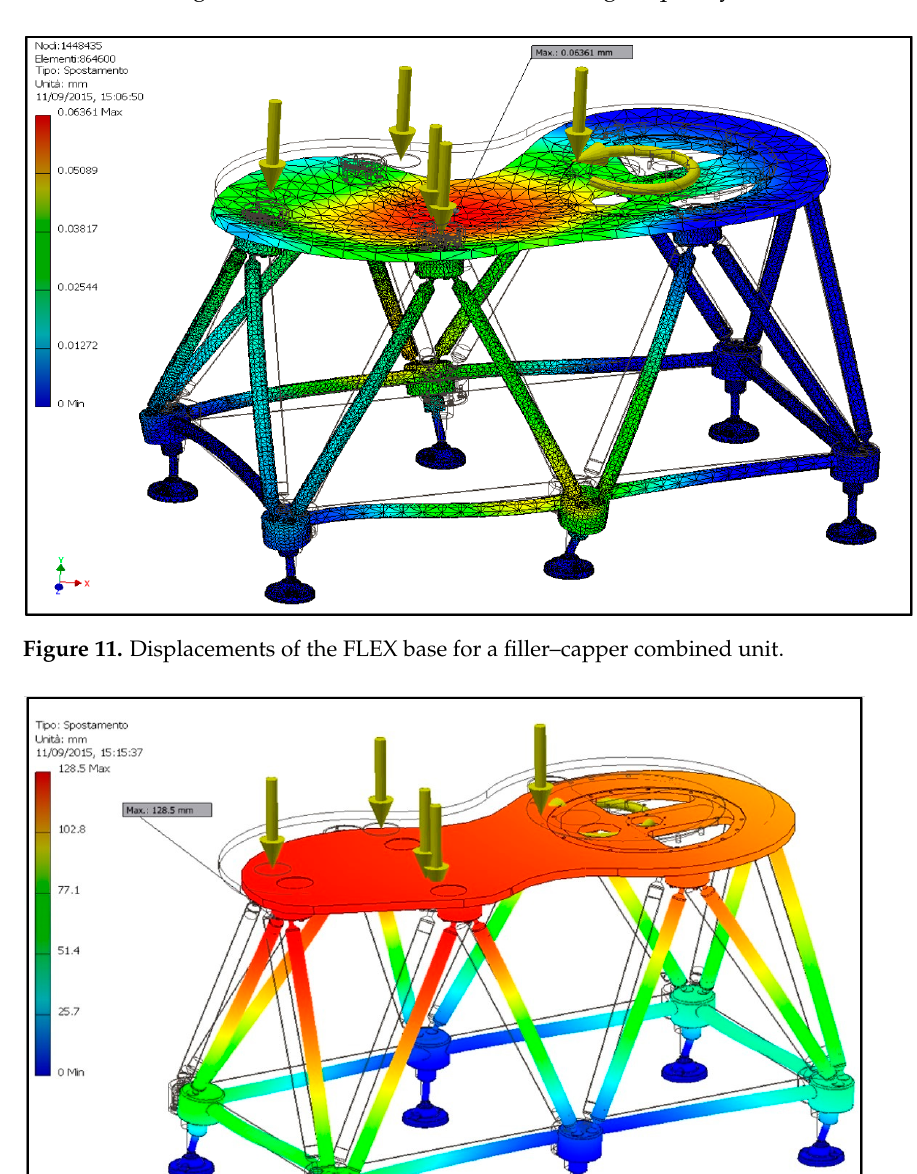
Figure 10. FLEX base model for a filler–capper combined unit.